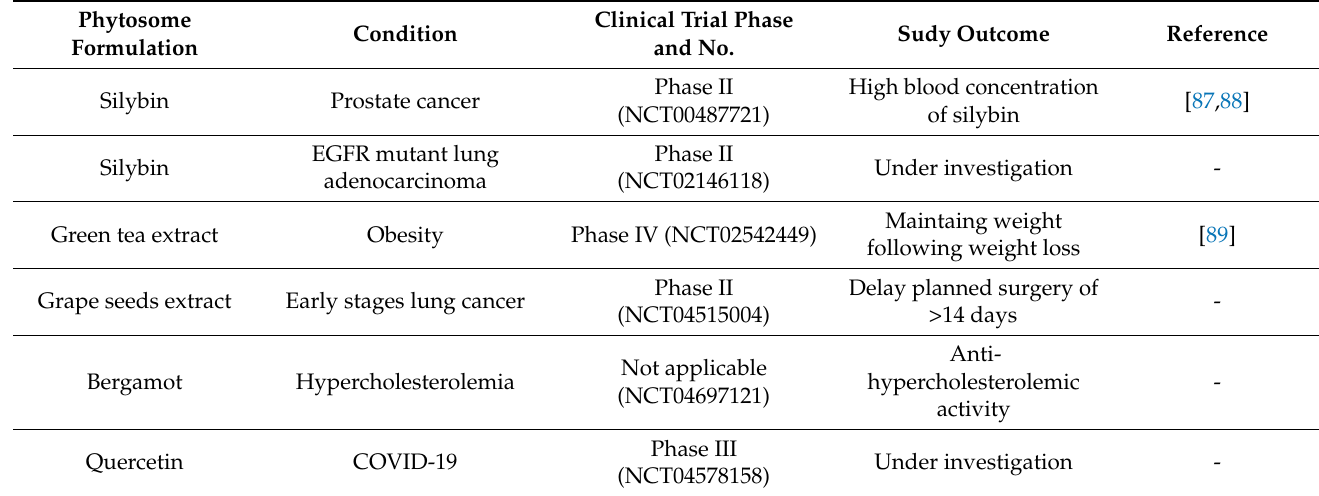
Table 2. Phytosome-based formulations on clinical trials. All data were obtained from www.clinicaltrials.gov, accessed on 28 August